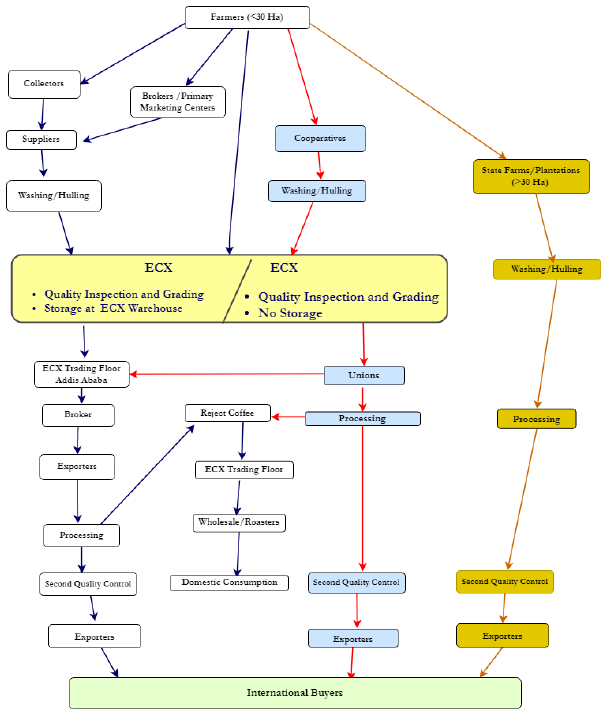
Figure 1. Coffee value chain in Ethiopia after implementation of the EXC before the reform of 2017.